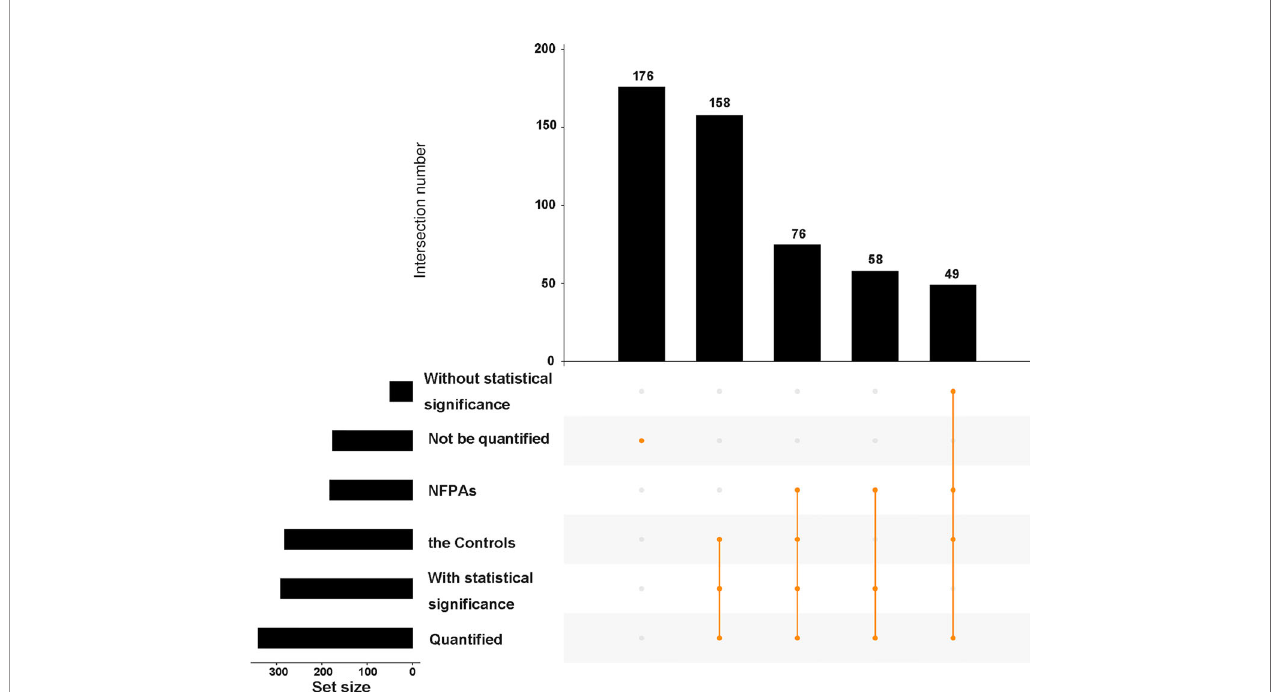
FIGURE 2 | An upset plot showing the overview of 517 identi fi ed acetylation sites in 296 proteins in NF-PitNETs relative to controls. All of the identi fi ed acetylation sites were classi fi ed into 6 groups according to whether quanti fi ed or not, whether with statistical signi fi cance or not and different sample sources. The horizontal bar chart on the left-hand side that shows the number of acetylation sites identi fi ed in NF-PitNET group, control group, statistically signi fi cant group, non-statistically signi fi cant group, quanti fi ed group, and non-quanti fi ed group. The intersection matrix in the center of the plot consists of rows that correspond to different groups, and columns that correspond to the intersection sets. The intersections between corresponding groups are presented as vertically connected fi lled orange circles (exclusive intersections sets). The top vertical bar chart shows the intersection size, the height of which represents the total number of acetylation sites included in the intersection. NFPAs =